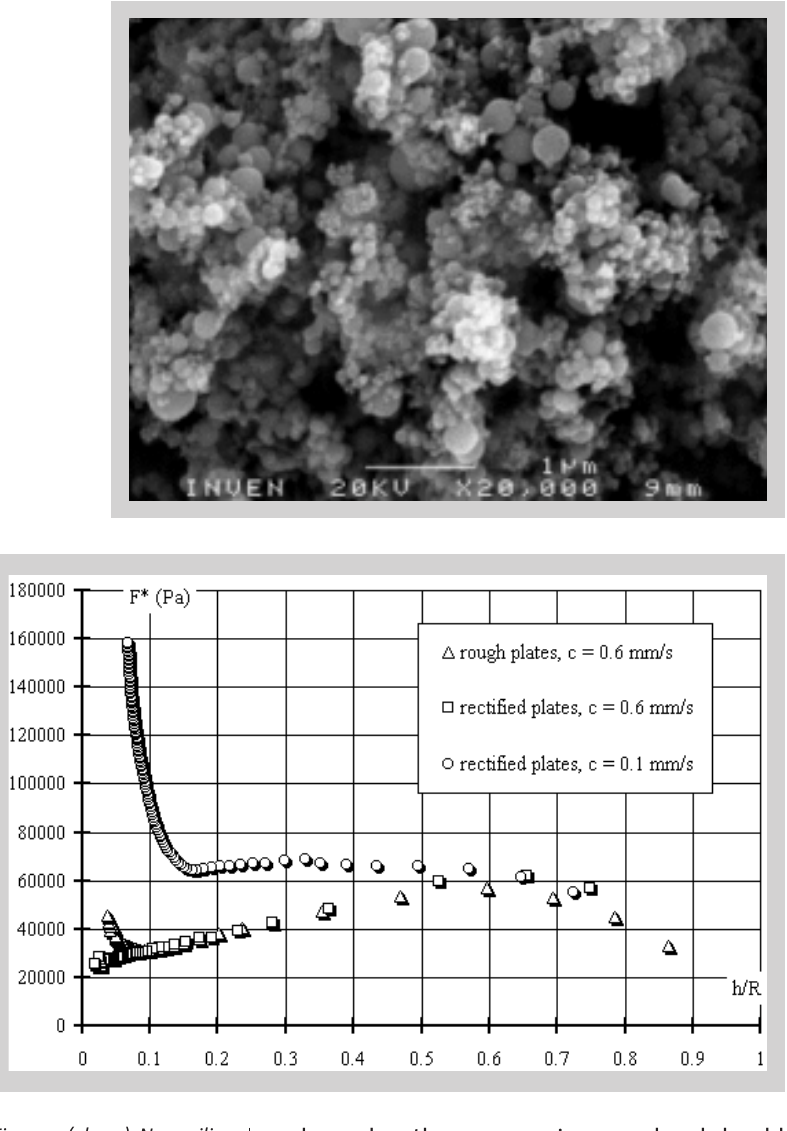
Figure 11 (above): Nano silica powder SEM pictures. The particle maximum size is about 200 nm. Figure 12 (below): Compression test of nano silica paste. Compared to the particle size, even the rectified plates seems to be